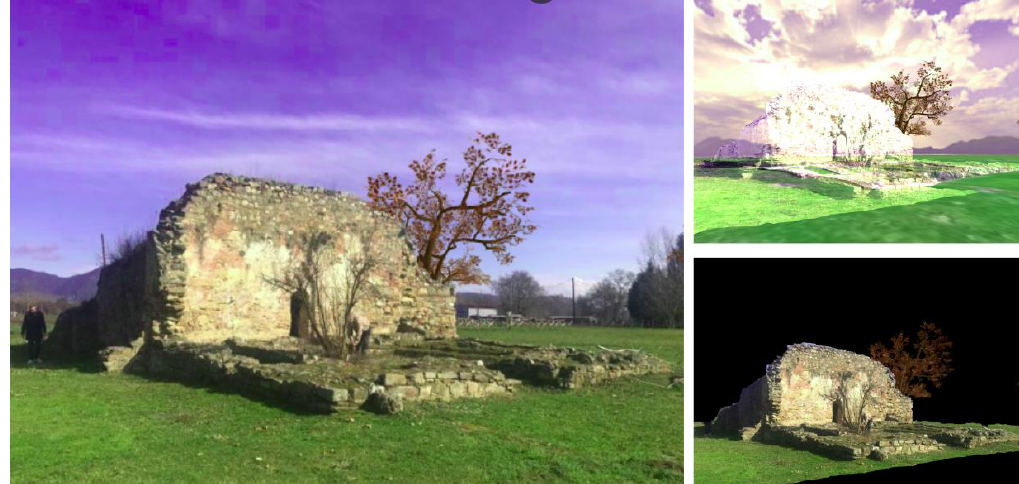
Figure 9. Implementing a mixed object (bath) and demonstrating occlusion of a virtual object (tree).